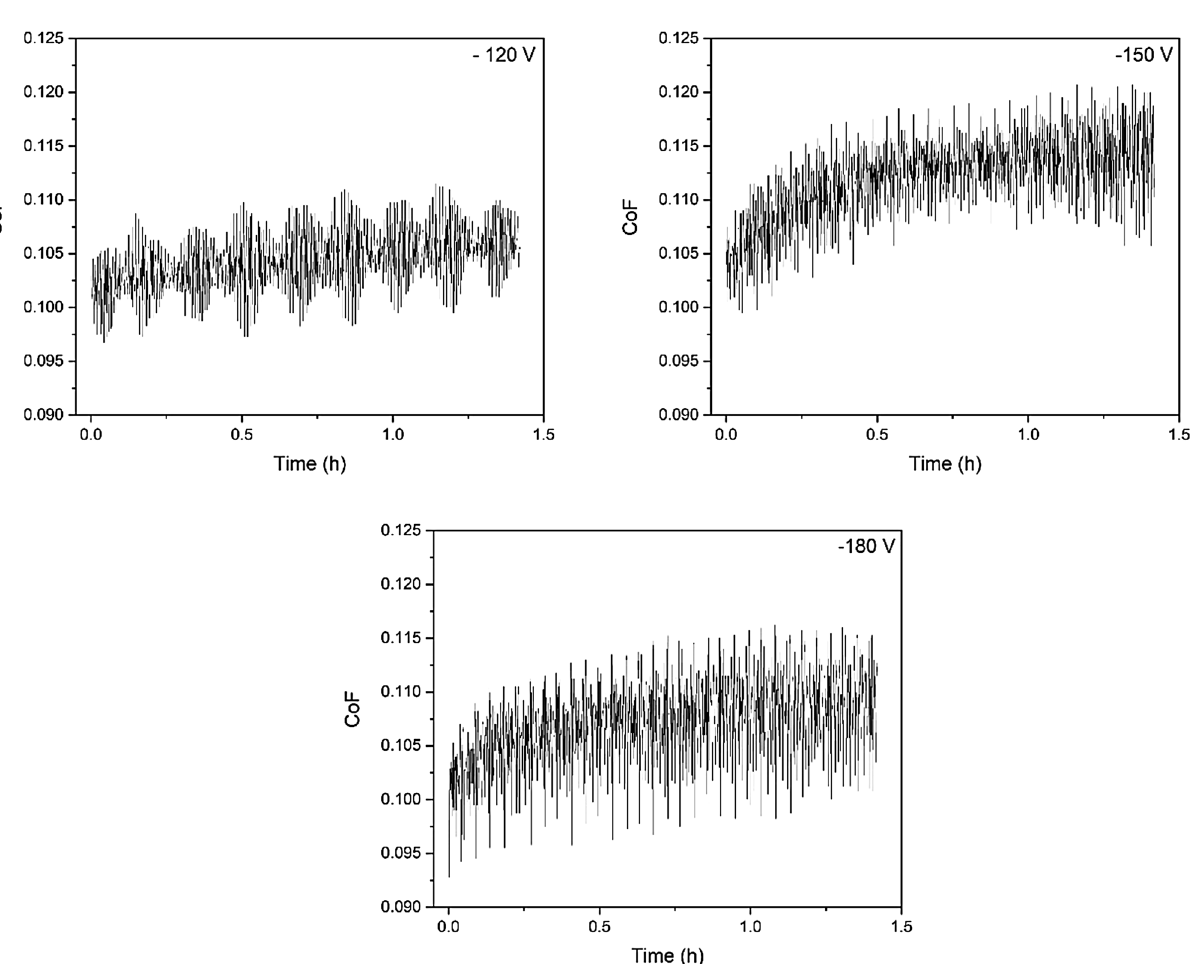
Figure 6. CoF evolution during wear tests for the multilayer coatings produced using different substrate bias